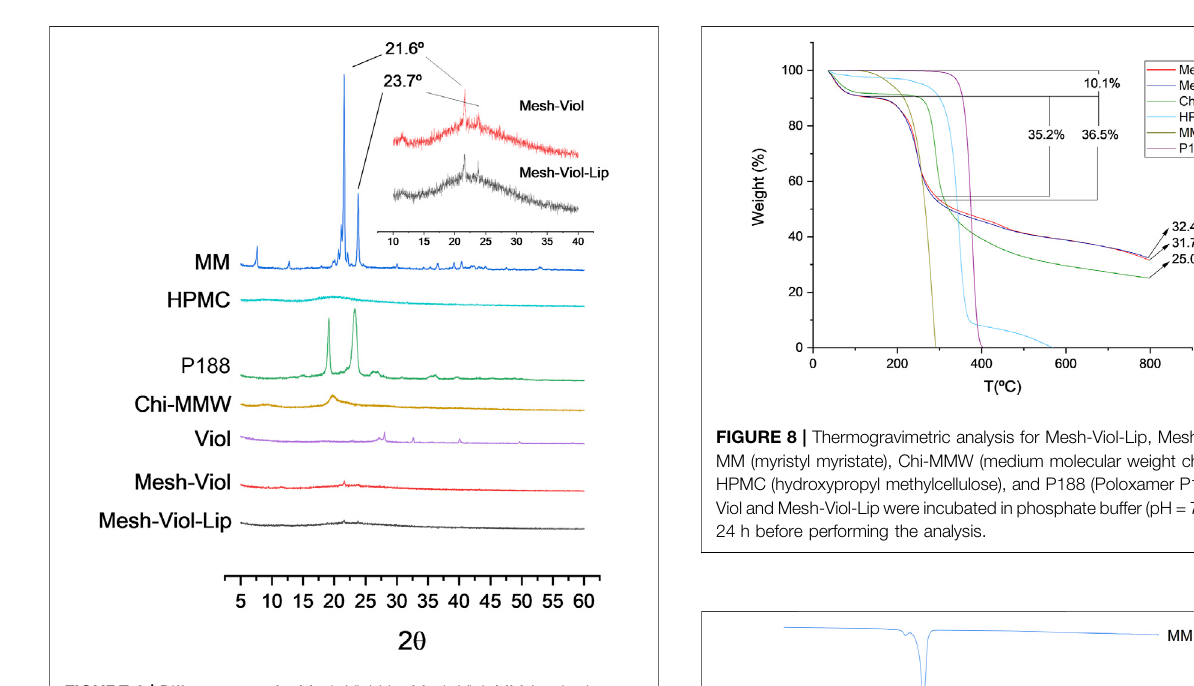
FIGURE 6 | Diffractograms for Mesh-Viol-Lip, Mesh-Viol, MM (myristyl myristate), Chi-MMW (medium molecular weight chitosan), HPMC (hydroxypropyl methylcellulose), and P188 (Poloxamer P188). Mesh-Viol and Mesh-Viol-Lip were incubated for Viol release in phosphate buffer (pH = 7.4) for 24 h before performing the analysis. Inset is a detail for Mesh-Viol-Lip and Mesh-Viol between 10 ° and 40 ° .